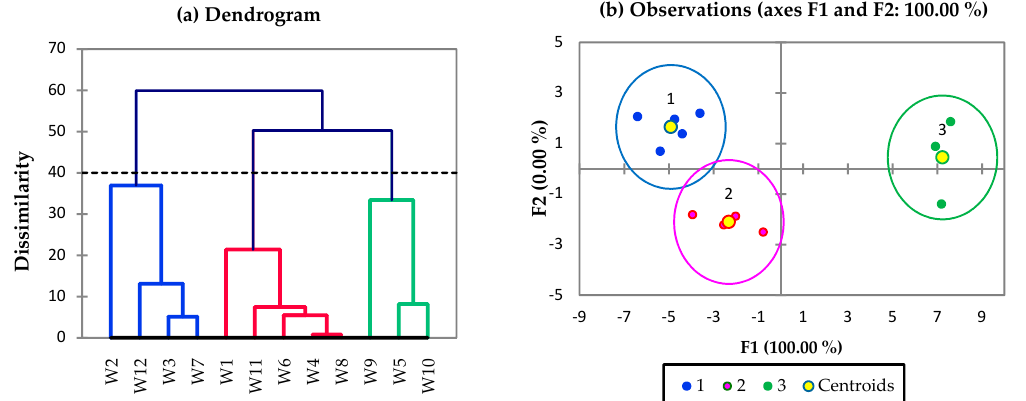
Figure 10. ( a ) Dendrogram showing spatial similarities of groundwater sampling locations using cluster analysis, ( b ) results from discriminant analysis crusted in 3 groups based on the distance metric. Ward agglomeration method and dissimilarity of euclidean distance was applied.